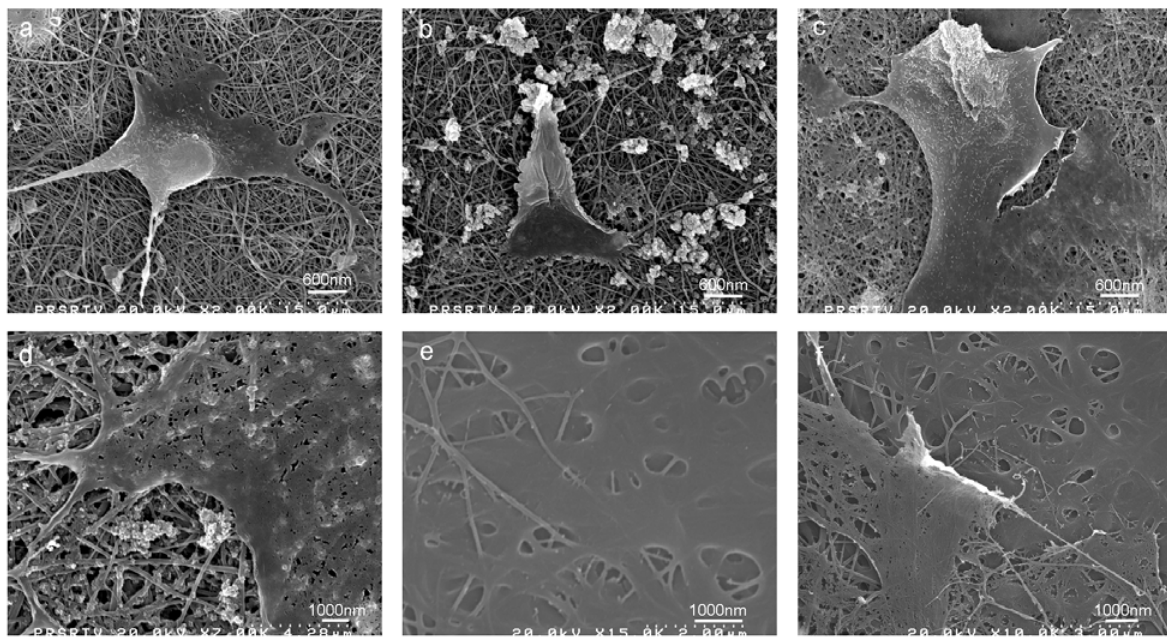
Figure 13. Osteoblasts on pure and mineralized silk/nHA nanofibers. ( a ) pure silk (day 1); ( b ) silk/nHA (day 1); ( c ) pure silk (day 2); ( d ) silk/nHA (day 2); ( e ) pure silk (day 7); and ( f ) silk/nHA (day